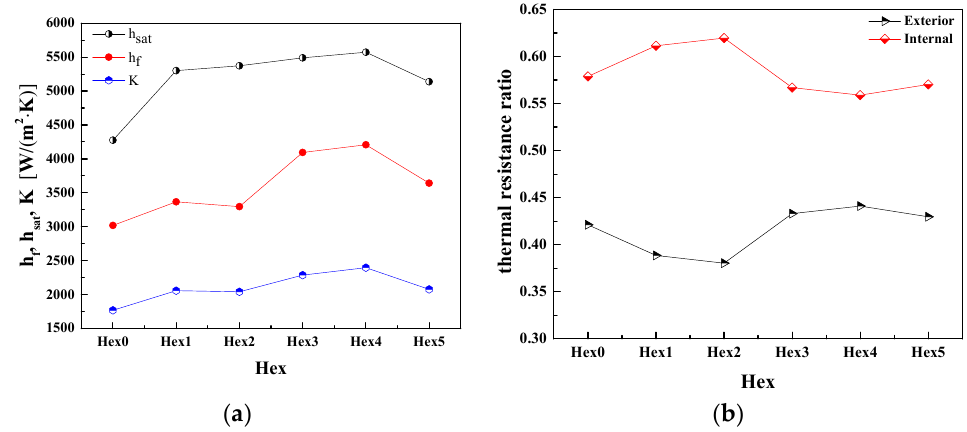
Figure 7. Comparison of heat transfer performance for Hex0~Hex5 ( a ) h f , h sat and K ( b ) Thermal resistance